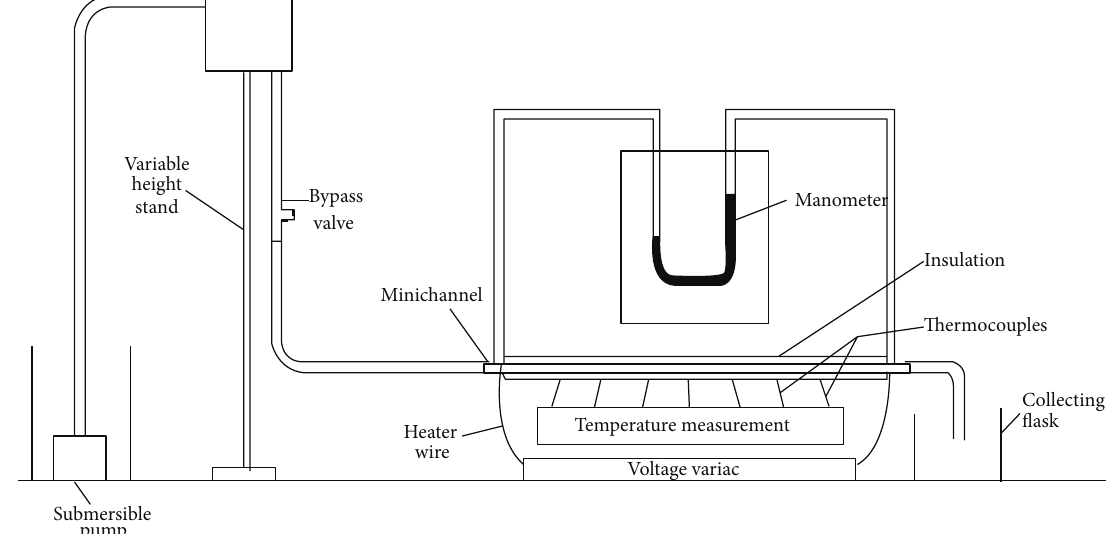
Figure 1: Experimental